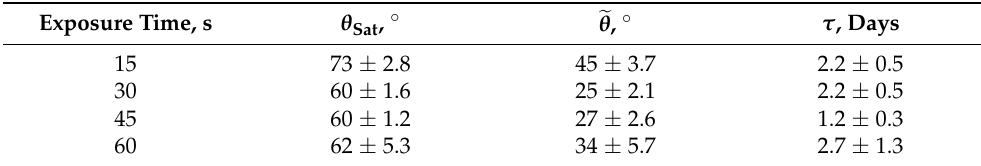
Table 2. Parameters of the exponential fitting of the kinetics of hydrophobic recovery following the Corona plasma treatment of PVC.